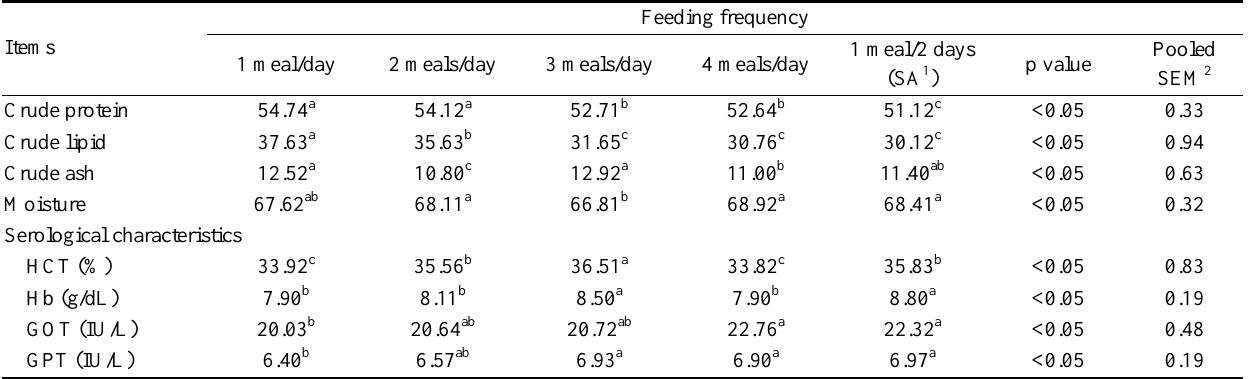
Feeding frequency